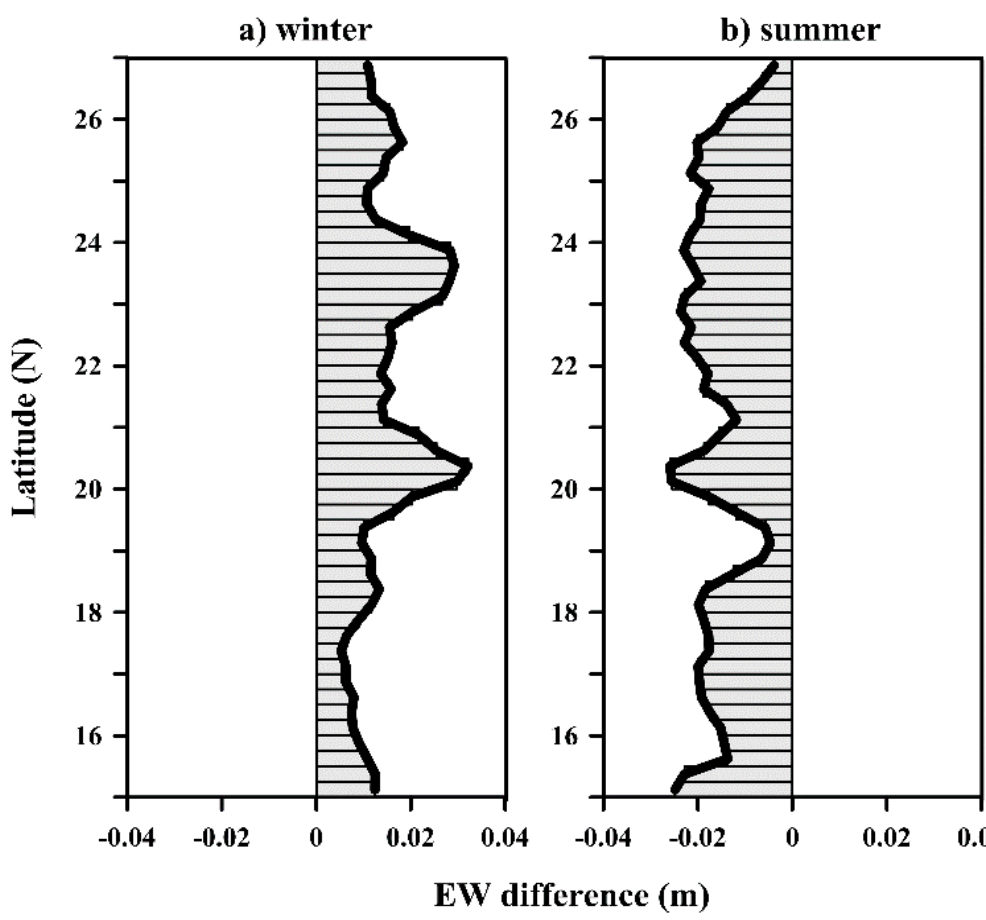
Figure 4. The mean EW difference during ( a ) winter and ( b ) summer.